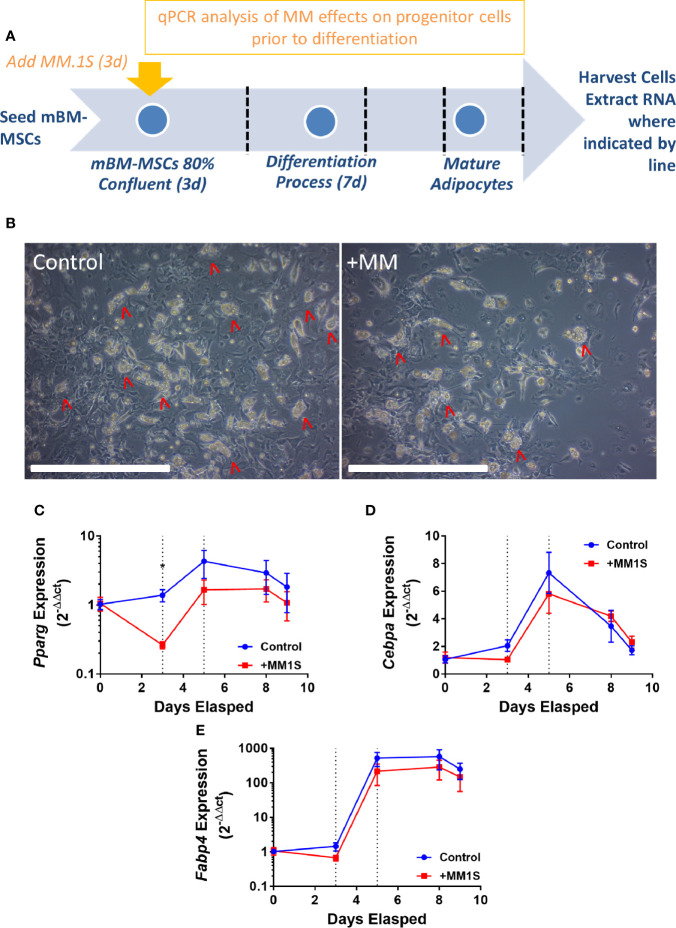
Mouse bone marrow mesenchymal stem cells (BM-MSCs) exposed to multiple myeloma (MM) cells via indirect co-culture in vitro exhibit reduced adipogenesis. Experimental design of co-culture experiment (A). Images taken with 10X objective (scale bars = 500 µm) at terminal differentiation following pre-exposure (day 9; B). Pparg
(C), Cebpa
(D), and Fabp4
(E) expression as assessed by qRT-PCR is suppressed in mouse MSCs “pre-exposed” to myeloma cells in vitro for 72-h prior to differentiation (first dotted line indicates the end of pre-exposure and start of differentiation), and levels are slightly suppressed throughout differentiation (second dotted line represents day 2 of adipogenic differentiation) (n=3); *p ≤ 0.05.